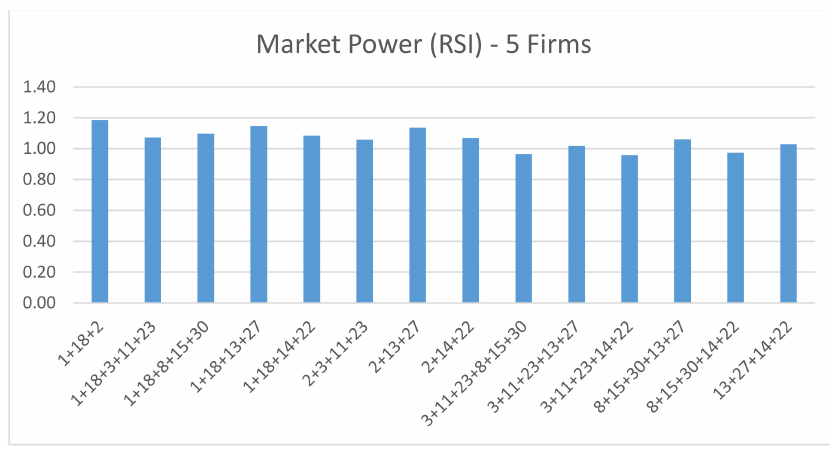
Figure 12. RSI for 5 firms’ setting